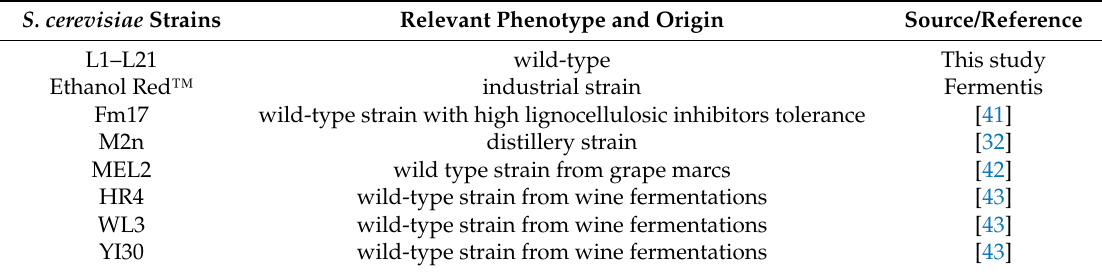
Table 1. S. cerevisiae strains used in this